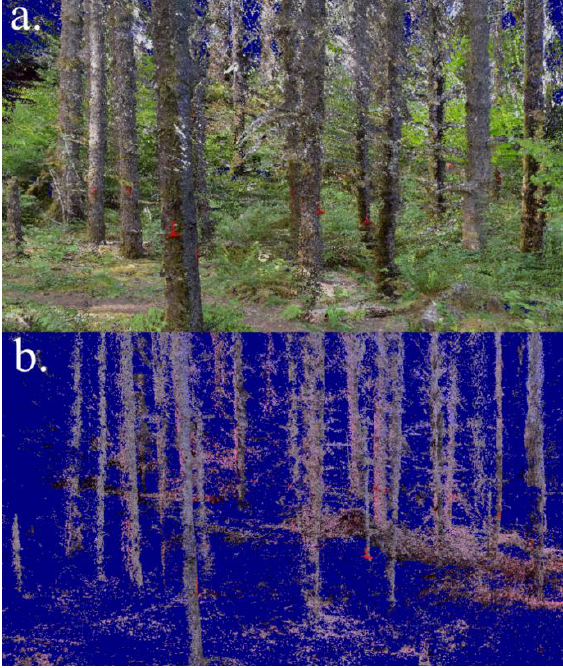
Figure 6. Preparing the PPC for estimation of the relative position of the trees shown at nadir in Figure 6. ( a ) perspective view of the raw PPC, ( b ) filtered PPC (points that are not mainly green or blue).